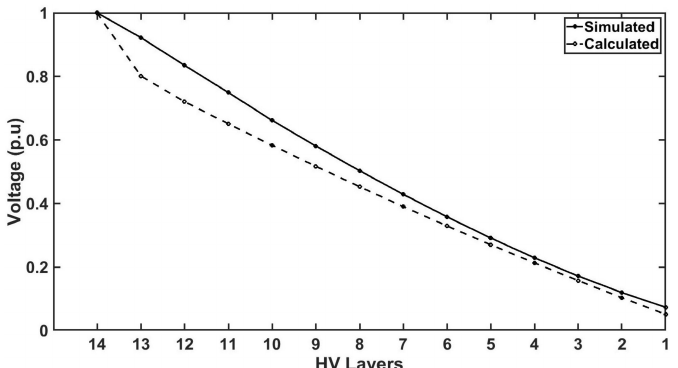
Figure 13. Comparison between simulated and calculated voltage distributions under standard lightning impulse for all layers of the unshielded